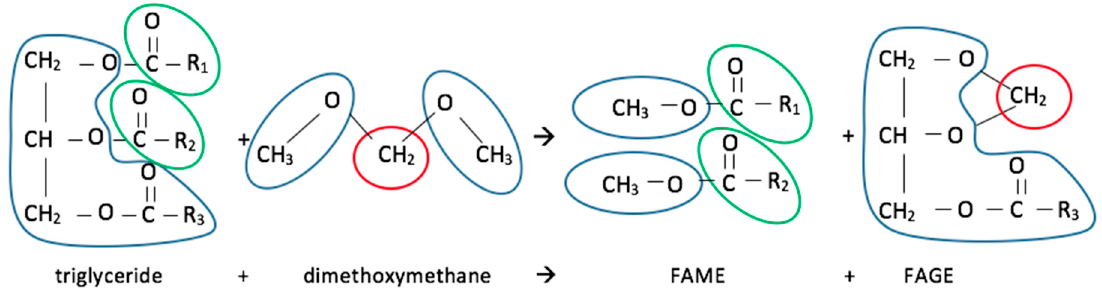
Figure 14. The transesterification-transketalization process of FAME+FAGE production.